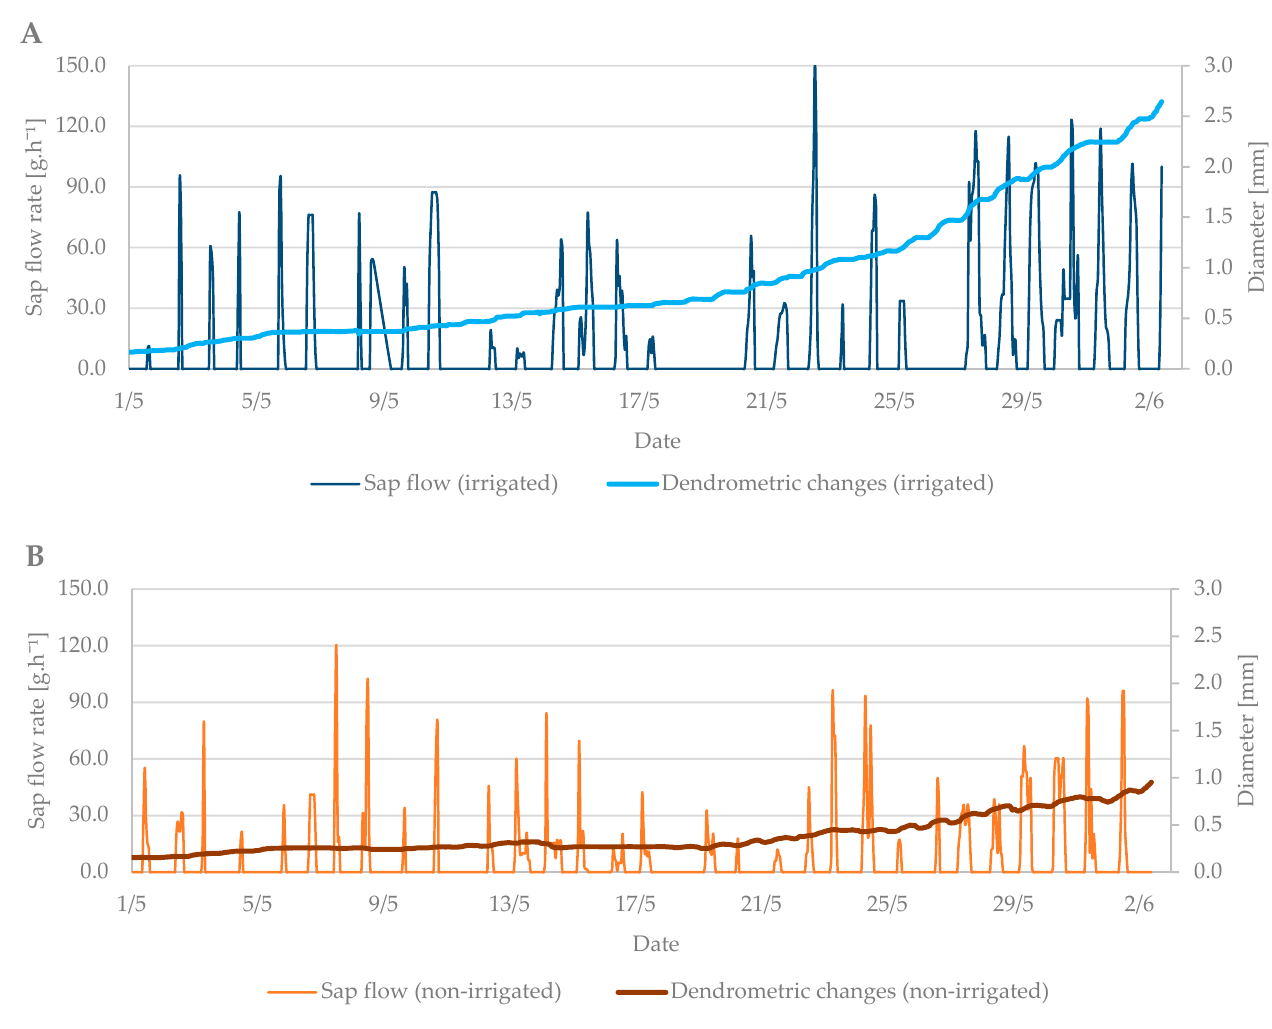
Figure 7. The shrinkage of stem diameter of the irrigated ( A ) and non-irrigated ( B ) trees during the flowering period in 2019 in comparison to the sap flow rate.